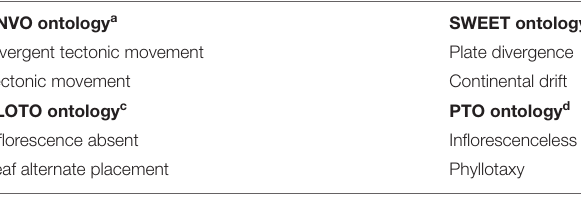
TABLE 1 | The examples of heterogeneous ecology and biodiversity ontologies. ENVO ontology